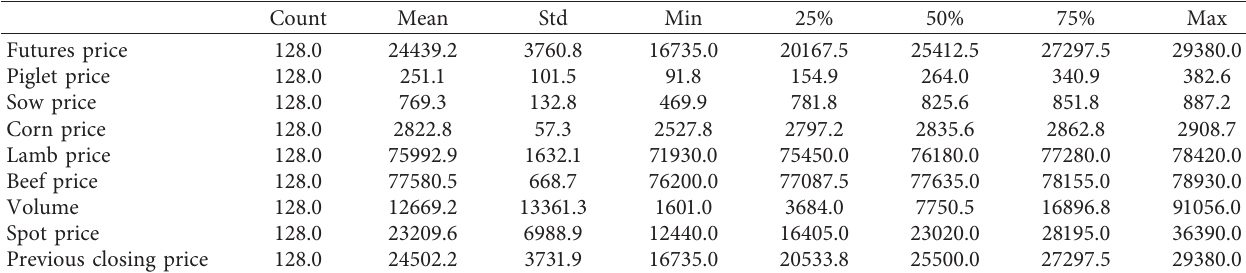
Table 4: Descriptive statistics of hog futures price data.